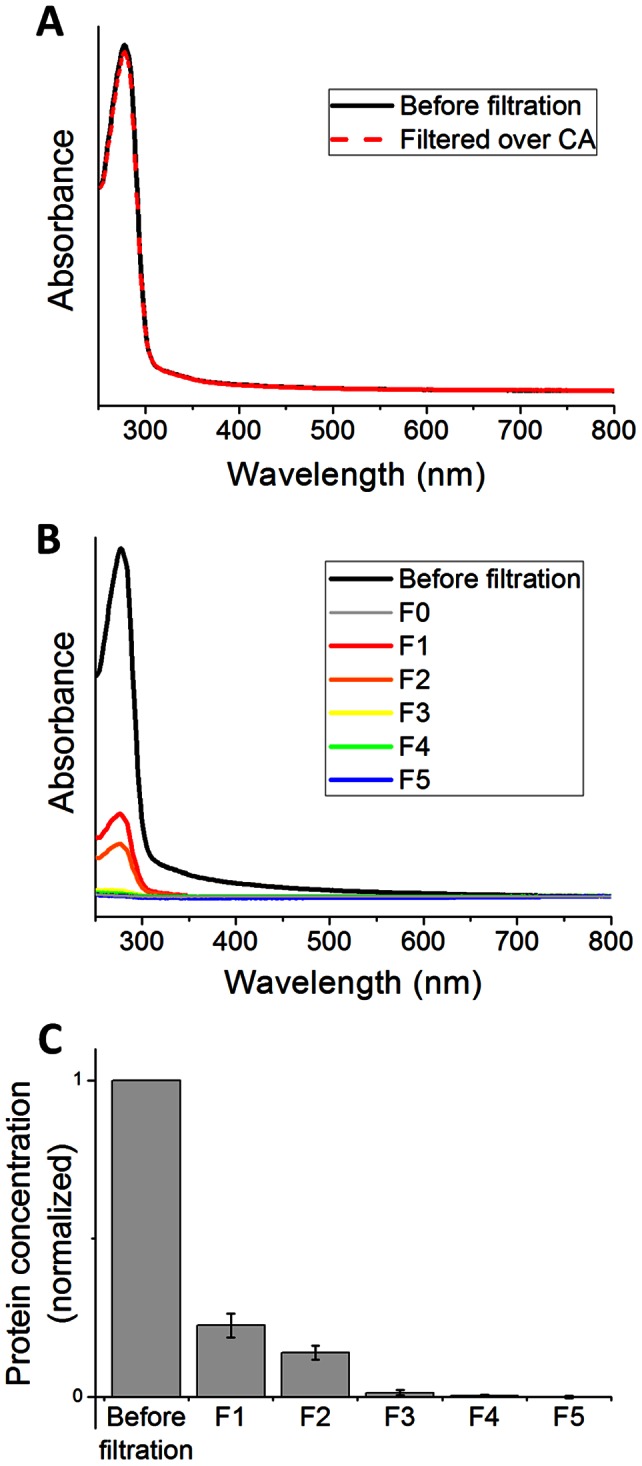
Filtration of protein mixtures.(A) UV/Vis spectra of the protein mixture before and after filtration over the pristine CA membrane. (B) Representative UV/Vis spectra of the protein mixture before filtration through the supramolecular membrane, the filtrate (collected in 5×1.5 ml fractions, F1–F5), and filtered buffer solution as a reference (F0) (C) Total protein concentration in the filtrate fractions F1–F5 as compared to the feed solution, determined from absorbance at 280 nm. Error bars correspond to the standard deviation of 5 independent filtration experiments.